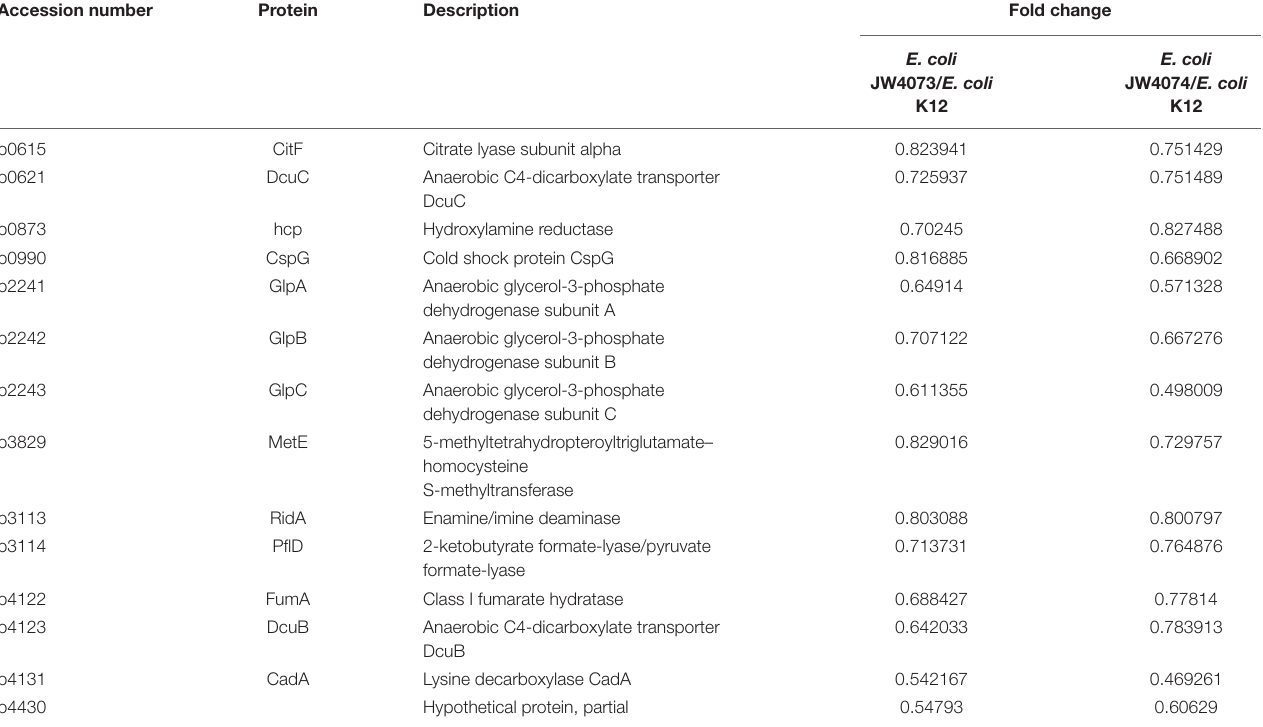
TABLE 3 | The BasS/BasR TCS regulates changes in protein expression in E. coli JW4073 and E. coli JW4074. Accession number